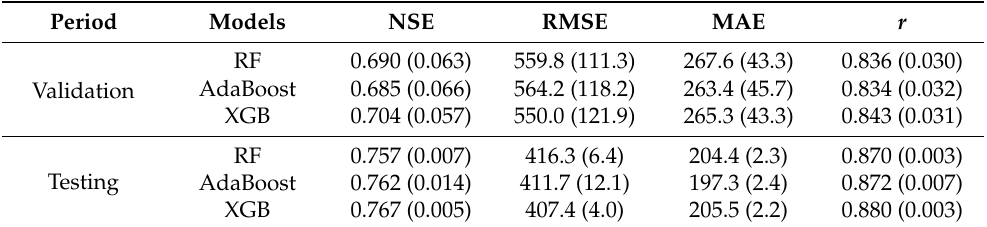
Table 2. Evaluation criteria for three base models (the values of RMSE and MAE are in m 3 /s).